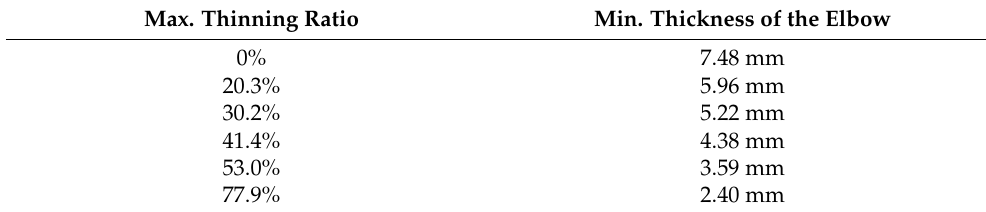
Figure 1. ( a ) Section view of a wall thinning curved pipe with 30% thickness at a 34-degree position and ( b ) loop combined with a thinning elbow. Table 1. The thinning thickness of six fabricated specimens.